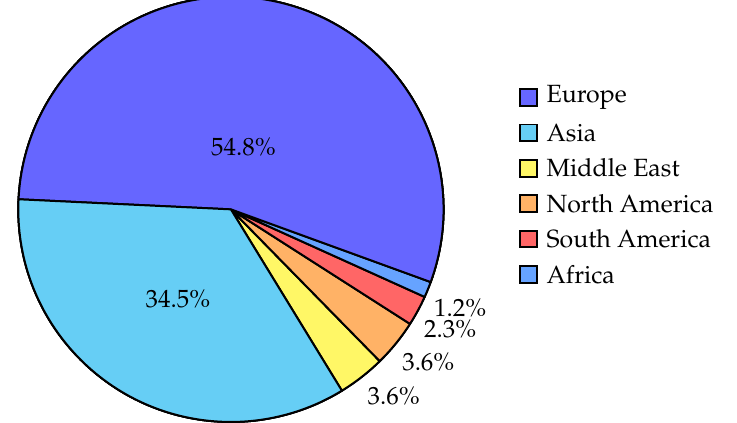
Figure 6. Distribution of campaigns by geographical